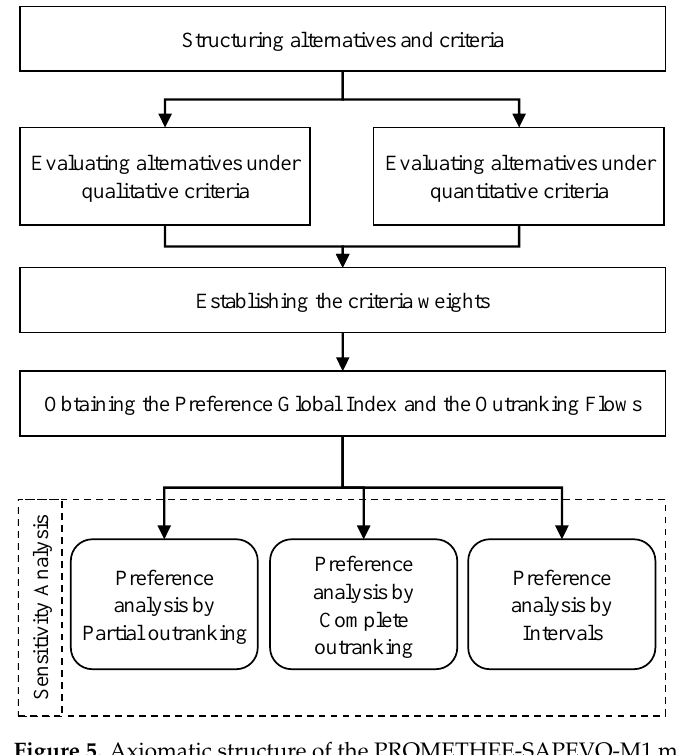
Figure 5. Axiomatic structure of the PROMETHEE-SAPEVO-M1 method.